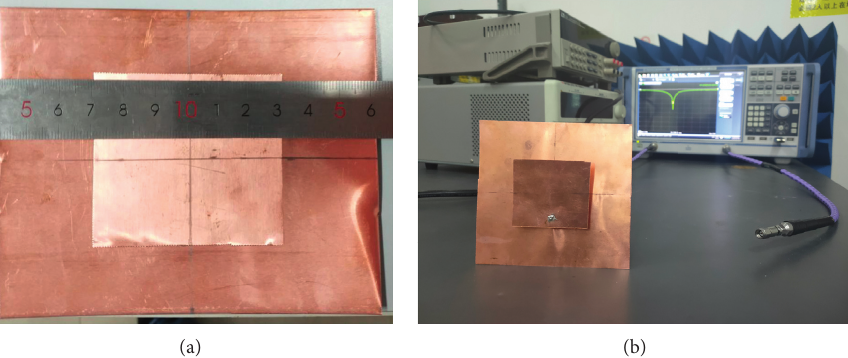
Figure 12: Fabricated air microstrip antenna. The (a) top view and (b) photo of the measured antenna prototype.